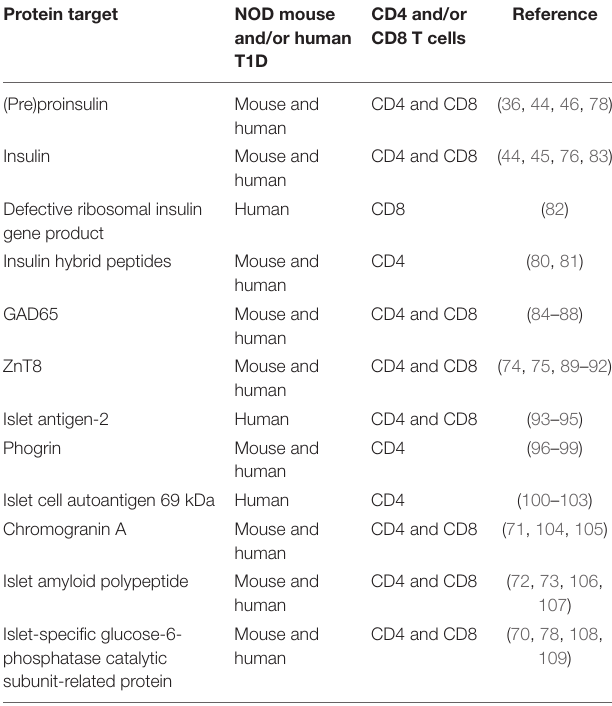
TABle 1 | Beta cell secretory granule-derived auto